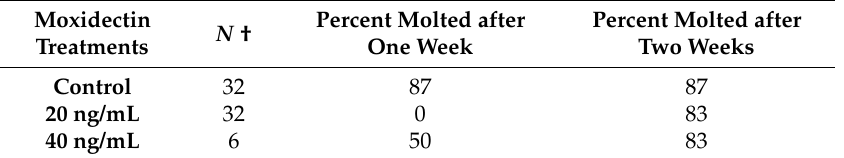
Table 5. Percentages of bed bug nymphs molted after the second moxidectin feeding.